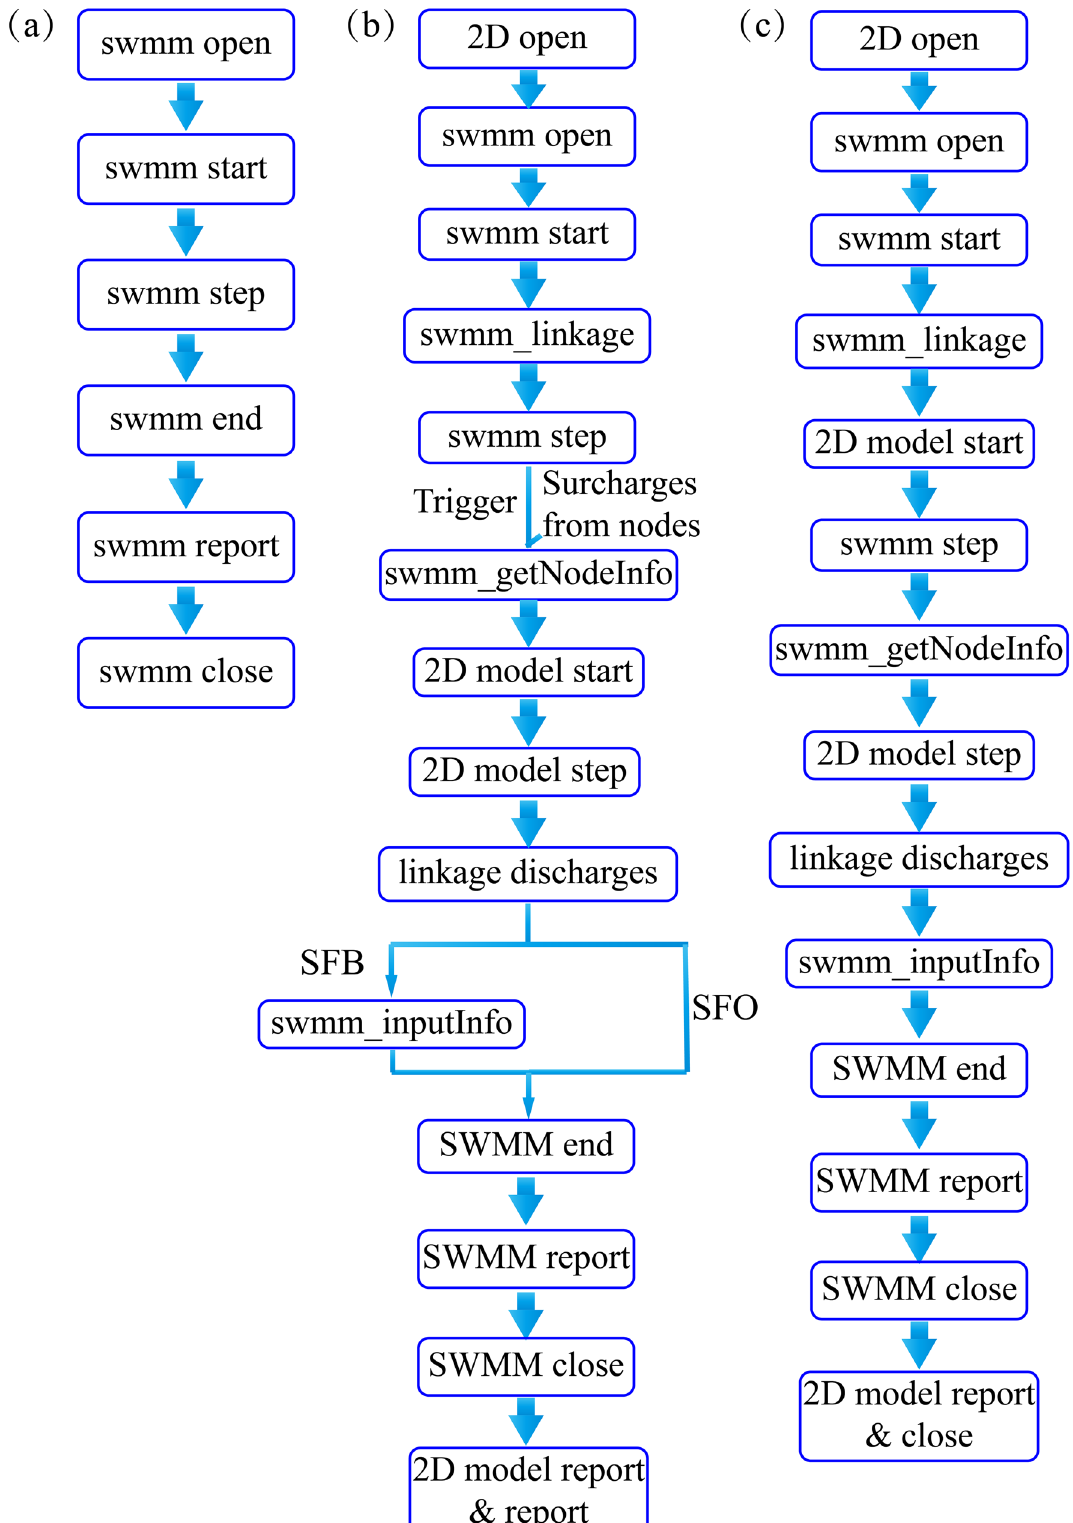
Figure 1. Methodology model structure. ( a ) SWMM original structure. ( b ) SF method structure. ( c ) FS method